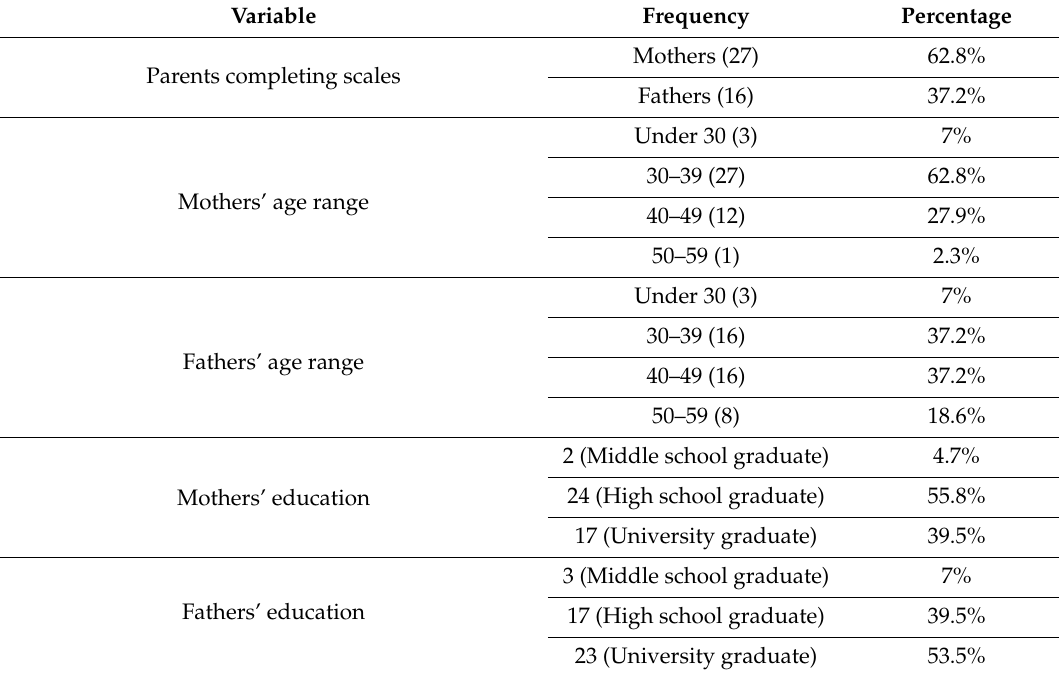
Table 1. Parental demographic